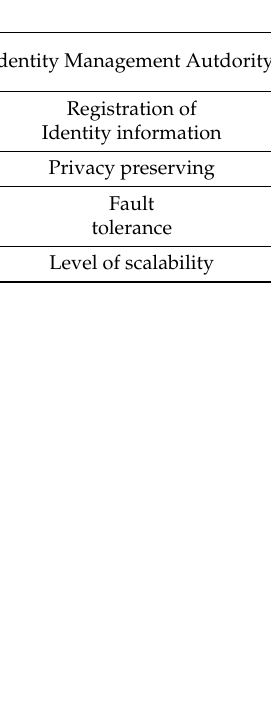
Table 1. Characteristics of